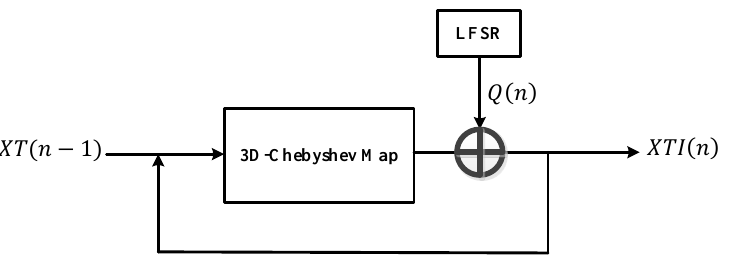
Figure 3. 3D-Chebyshev map coupled with the used LFSR using a XOR operator. At the bottom of Figure 2g–l, we give the corresponding histogram for each chaotic map, the 32-bit LFSR, and the coupled 3D-Chebyshev map with the 32-bit LFSR. We notice that, visually, the histograms obtained by the chaotic maps are not uniform, except for the 32-bit LFSR and the discrete 3D-Chebyshev coupled with the 32-bit LFSR. This observation is asserted by the obtained experimental and theoretical results of the chi-square tests given in Table 1. Table 1. Chi-square results on the tested histograms. Chi-Square